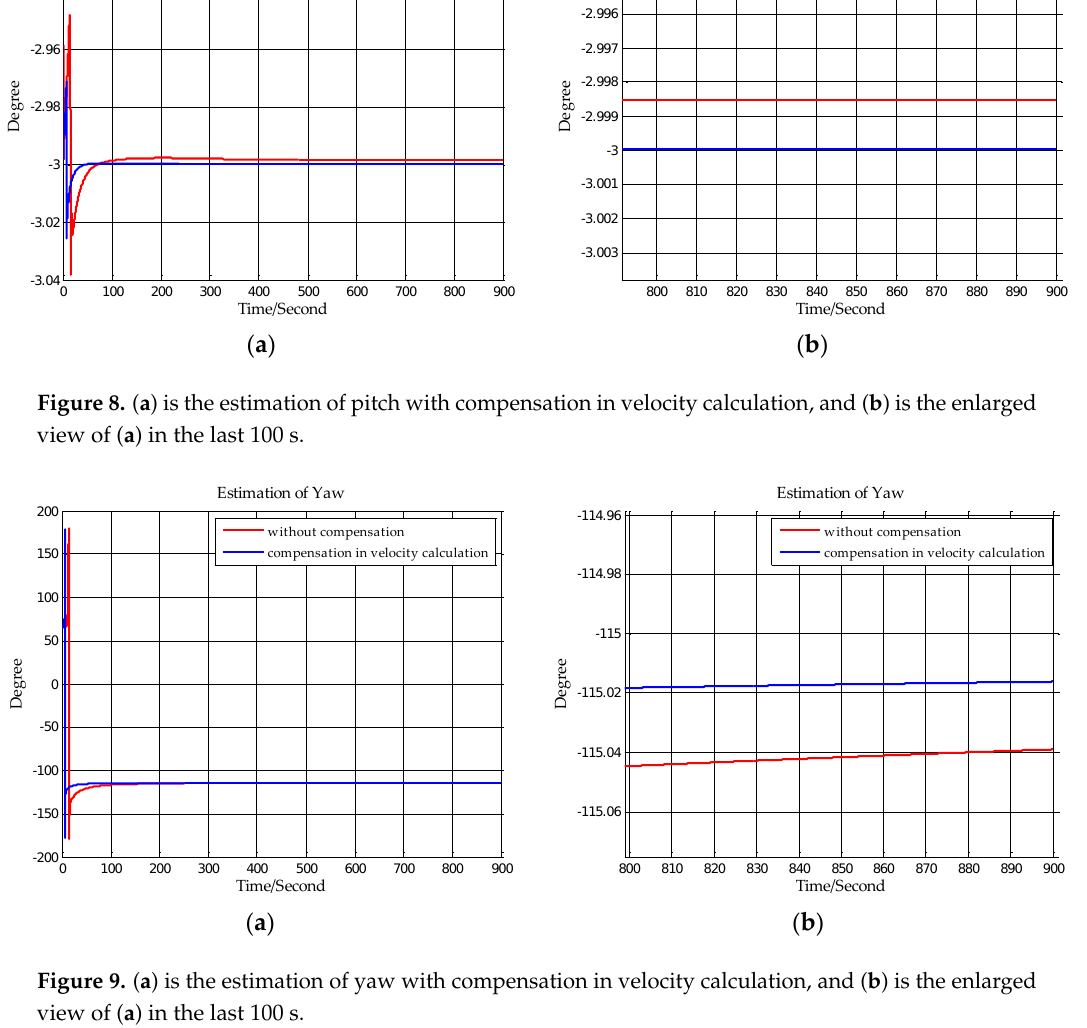
Figure 9. ( a ) is the estimation of yaw with compensation in velocity calculation, and ( b ) is the enlarged view of ( a ) in the last 100 s. Sensors 2018 , 18 , x FOR PEER REVIEW